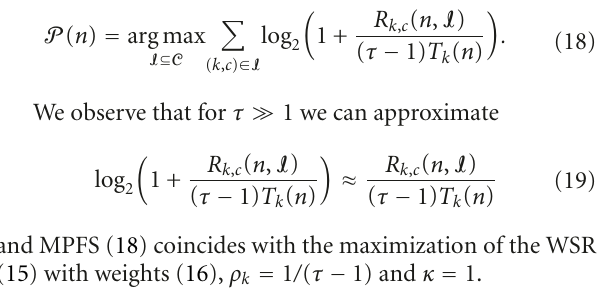
algorithm, the introduction of a new candidate stream ( k , c